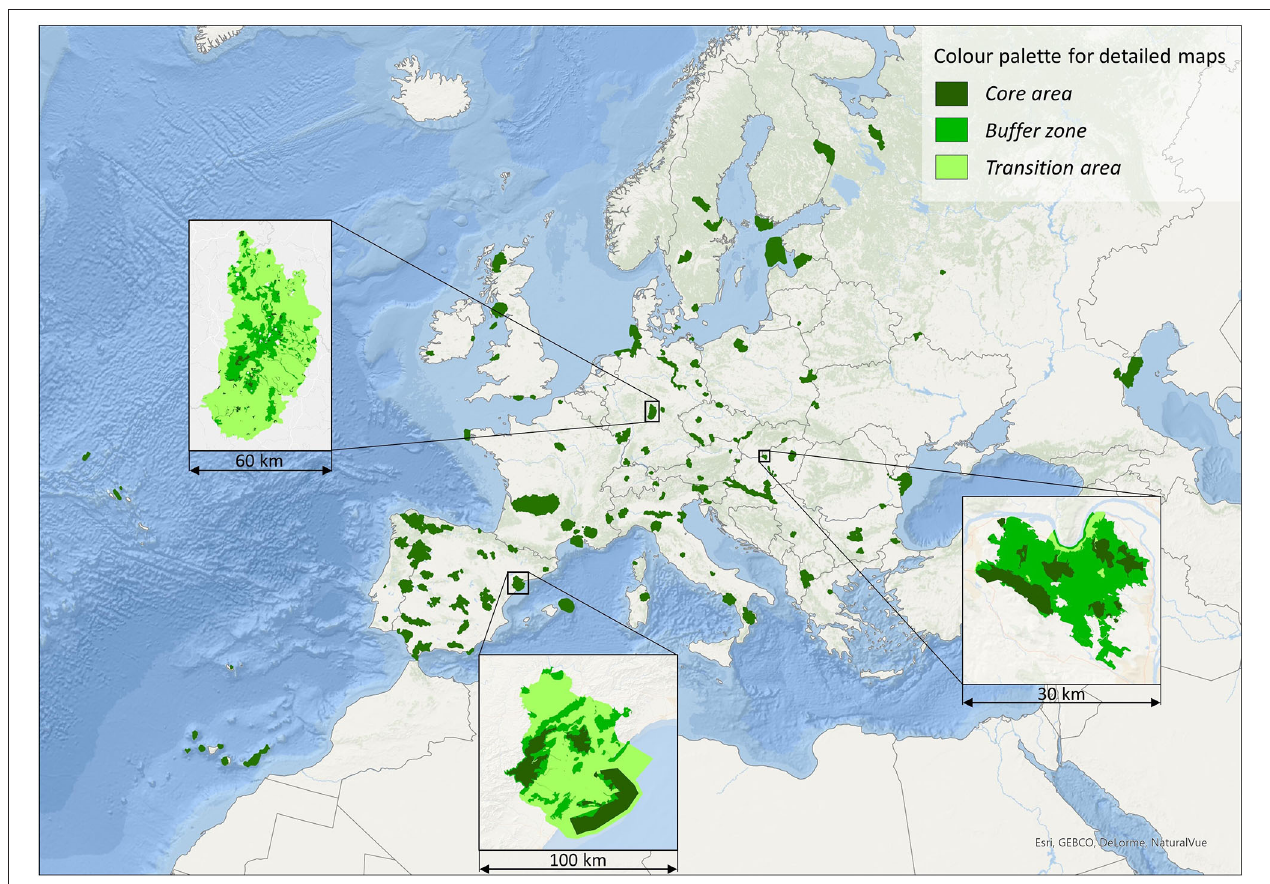
FIGURE 1 | Overview map of 153 European biosphere reserves included in this dataset (dark green areas; no zones depicted due to perceptibility) and detailed maps of the zoning of three exemplary biosphere reserves, Pilis (Hungary), Rhön (Germany), Terres de l’Ebre (Spain). All maps projected in EPSG:3035.